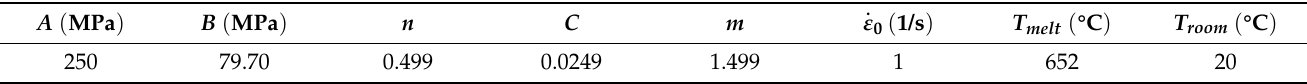
Table 4. Johnson–Cook material model’s constants of the of AA6061-T6 (reprinted with permission from [5], 2023, Licence No 5513161238525, Springer nature).